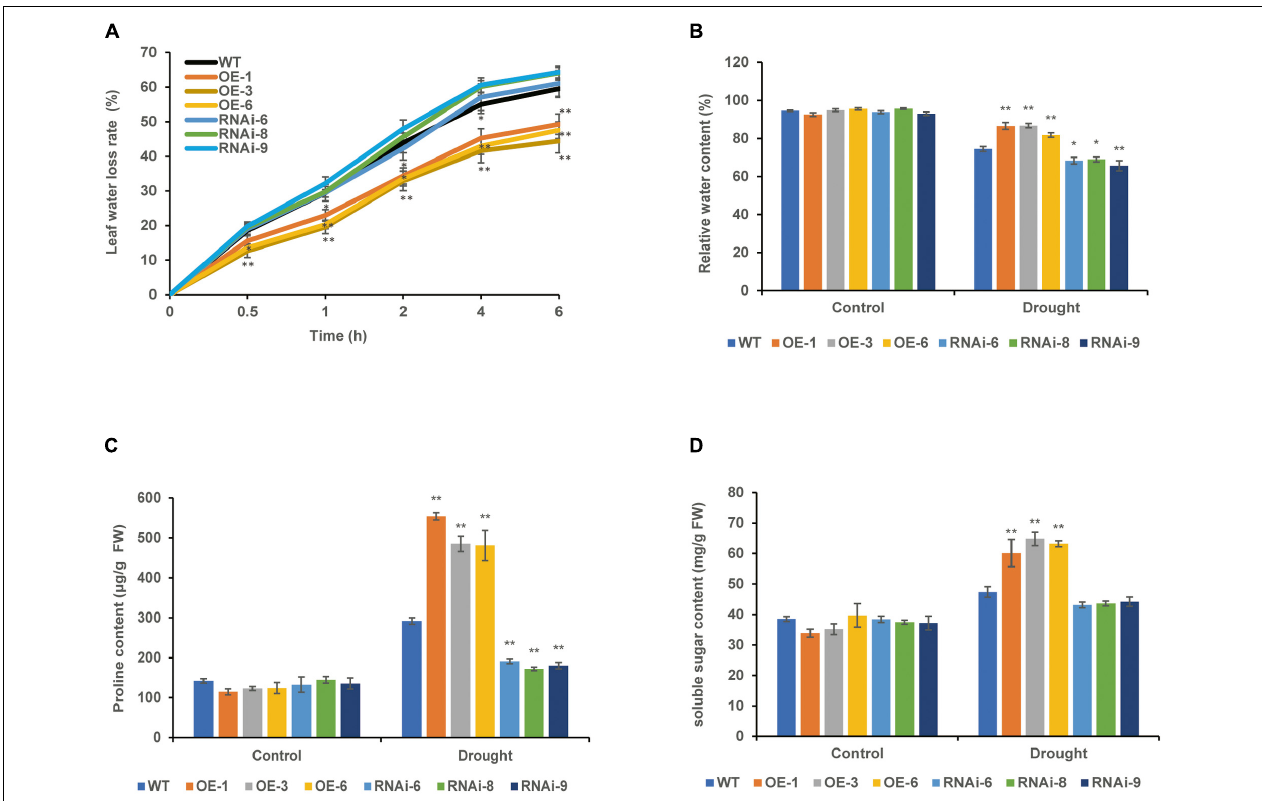
FIGURE 5 | Effect of drought stress on the water status of WT and transgenic wheat. (A) Leaf water loss rate of 4 weeks WT and TaNRX1 transgenic wheat ( n = 15). (B) Relative water content of 4 weeks WT and TaNRX1 transgenic wheat in normal water supply and 10 days of drought stress ( n = 6). (C) Proline content ( n = 4). (D) Soluble sugar content ( n = 4). Data represent the mean ± SD. WT, wild type; OE-1–OE-6, TaNRX1 overexpression T 3 homogeneous lines; RNAi-6–RNAi-9, TaNRX1 RNA interference T 3 homogeneous lines. * P < 0.05, ** P < 0.01 represent the significant difference between the transgenic line and the WT,